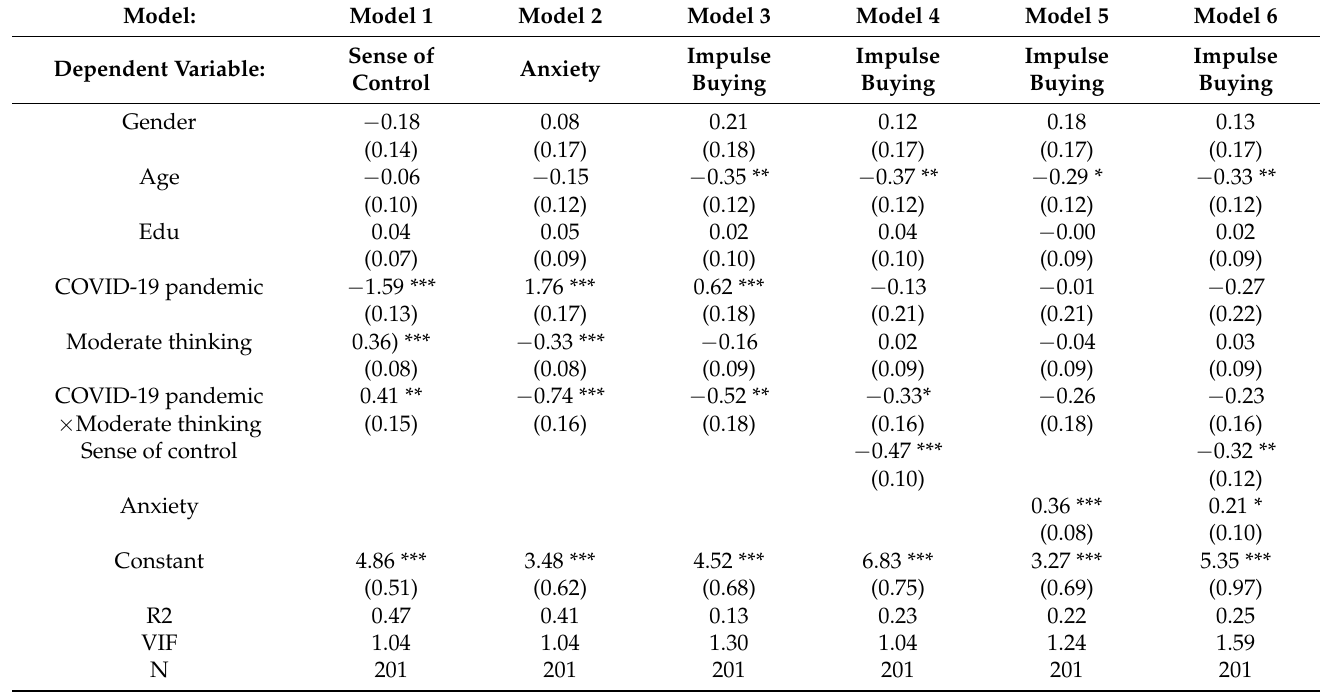
Table 1. Regression analysis